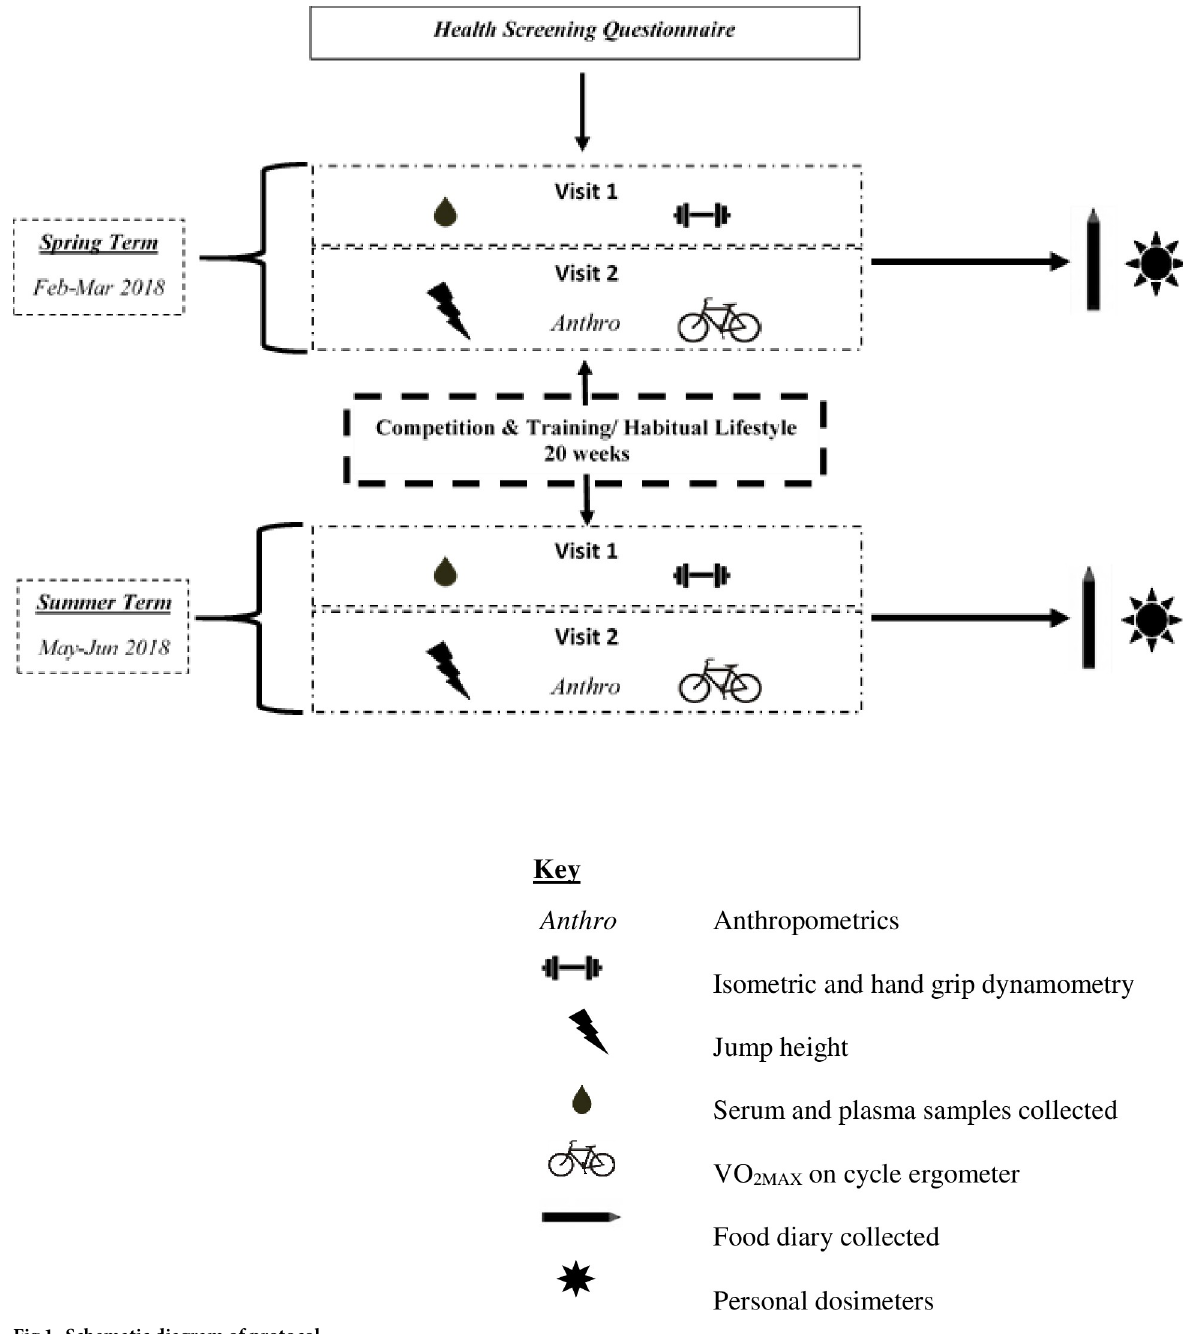
Fig 1. Schematic diagram of